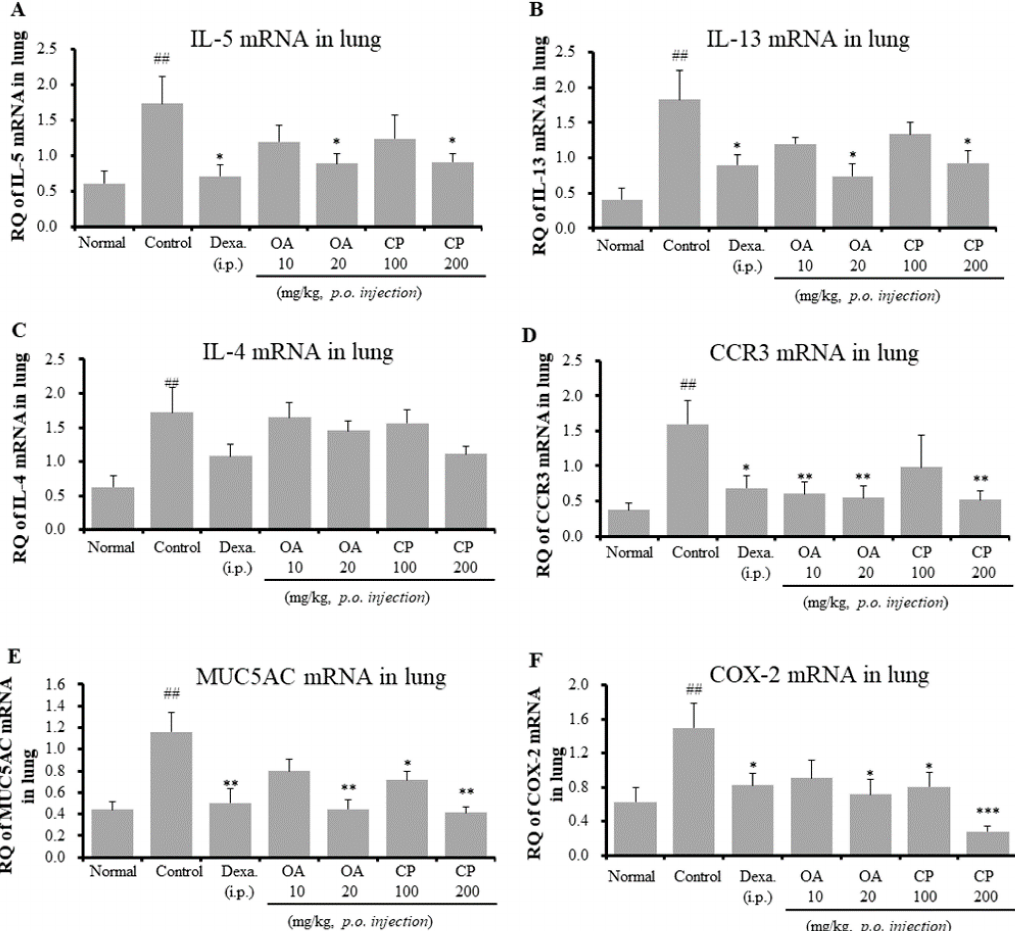
Figure 4. Effects of OA, CP, and Dexa on IL-5, IL-13, IL-4, CCR3, MUC5AC, and COX mRNA expression in the lung tissue in OVA-induced asthmatic model mice. IL-5 mRNA ( A ), IL-13 mRNA ( B ), IL-4 mRNA ( C ), CCR3 mRNA ( D ), MUC5AC mRNA ( E ), and COX-2 mRNA ( F ). Samples were analyzed by qRT-PCR. The results are expressed as relative quantification (RQ) to control. * p < 0.05, ** p < 0.01, and *** p < 0.001 for the OVA control group versus the experimental group comparisons. # p < 0.05, ## p < 0.01, and ### p < 0.001 for the OVA control group versus the normal group